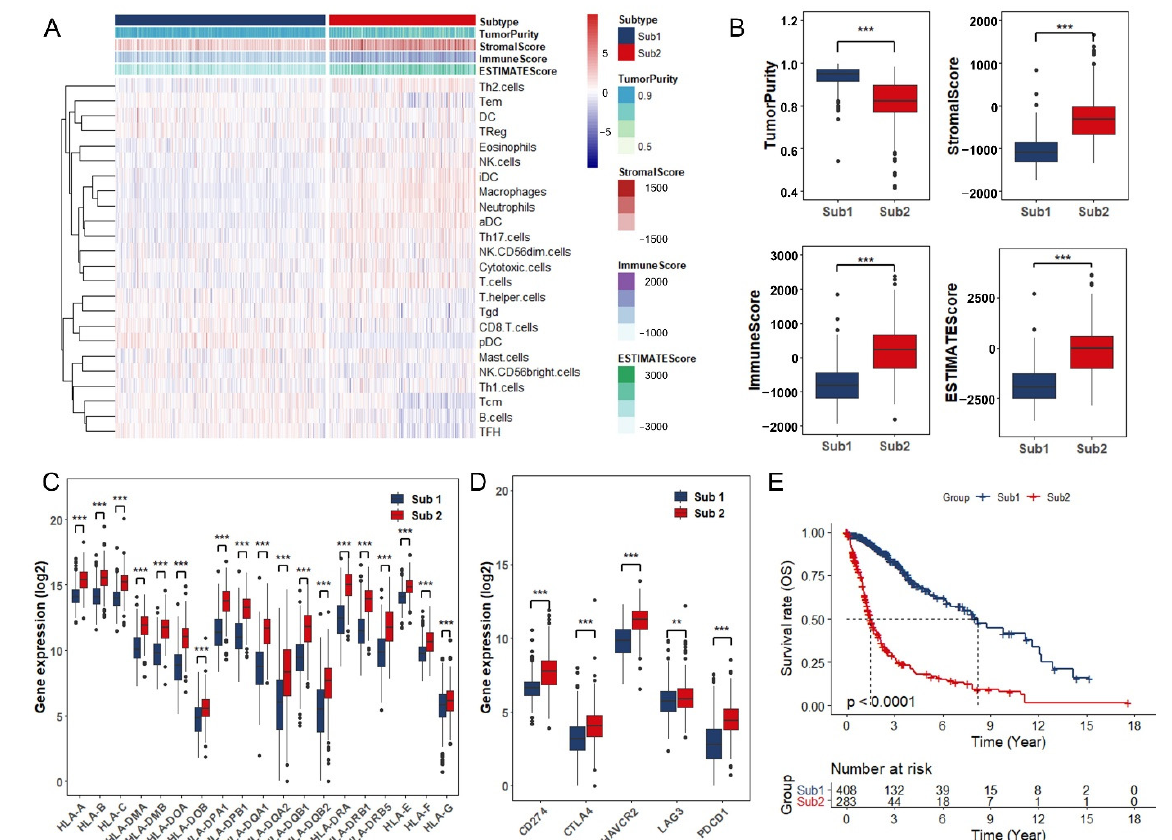
Figure 2. Glioma immune subtypes were identified based on the tumor-infiltrating immune cells: ( A ) Heatmap of ssGSEA scores for two subtype groups (Sub1= 408, Sub2 = 283). ( B ) Comparison of tumor purity, estimate score, immune score and stromal score between Sub1 and Sub2 in TCGA database. ( C ) The expression level of HLA family genes in Sub1 ( n = 408) and Sub2 ( n = 283) in TCGA database. ( D ) The expression level of CD274 (PD-L1), CTLA4, HAVCR2, LAG3 and PDCD1 (PD1) in Sub1 ( n = 408) and Sub2 ( n = 283) in TCGA database. ( E ) Kaplan–Meier curves of overall survival for Sub1 ( n = 408) and Sub2 ( n = 283) in TCGA database. **, p < 0.01; ***, p < 0.001.